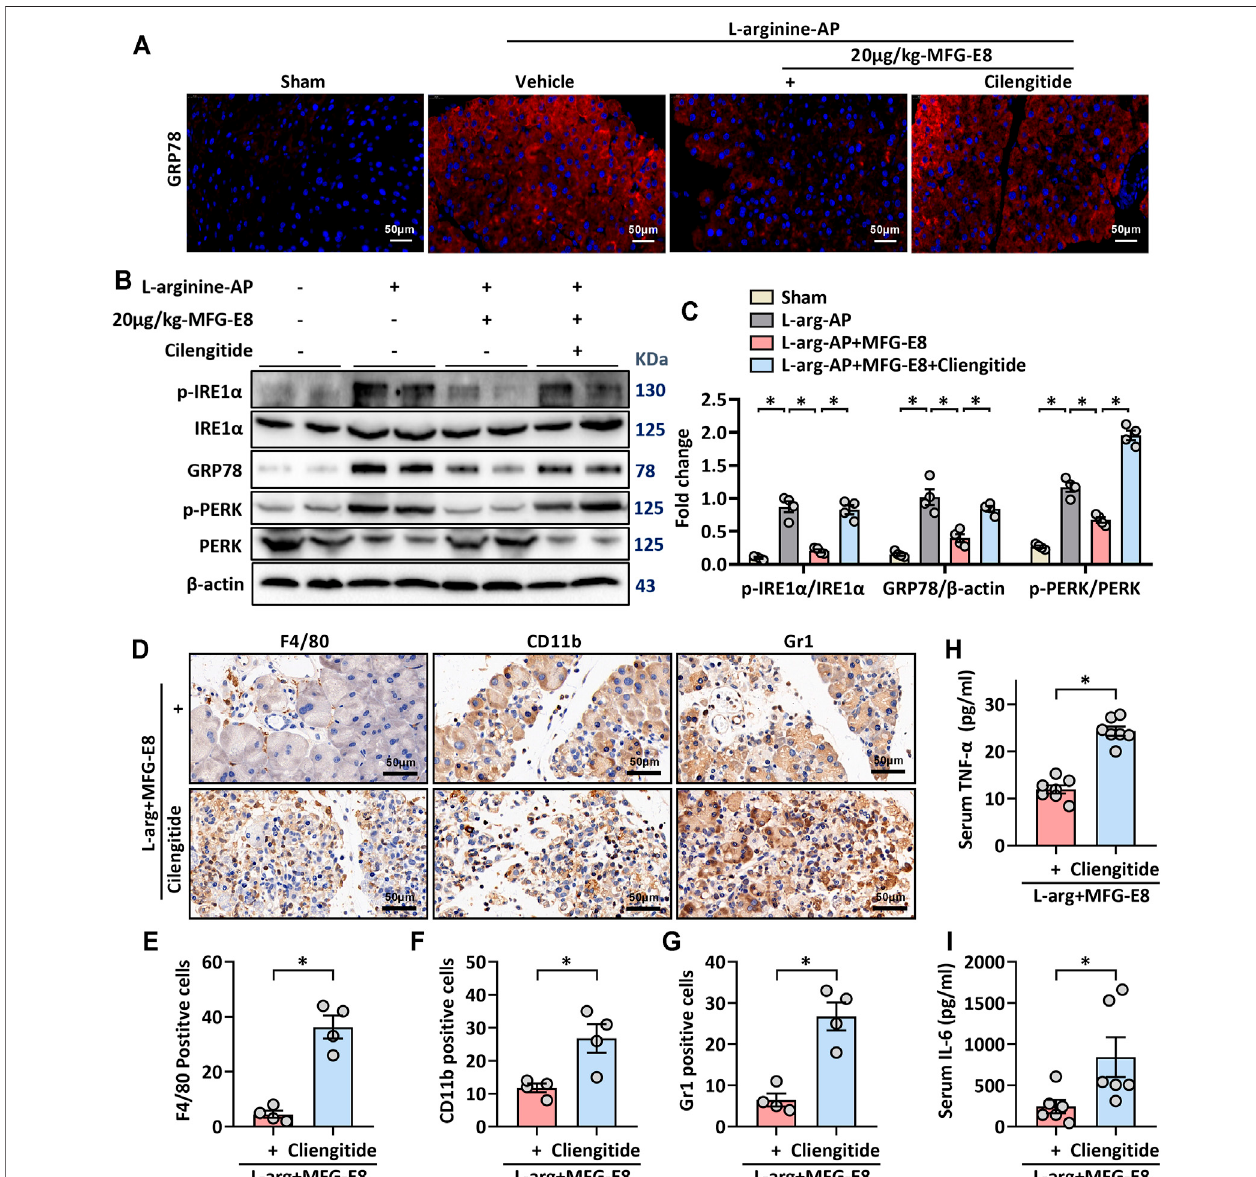
phospho-IRE1 α ,IRE1 α andCHOPinthepancreas; (D) RepresentativephotosofF4/80,CD11bandGr1staining; (E – G) QuantitativeofF4/80,CD11b,andGr1staining; (H) SerumIL-6levels; (I) SerumIL-6levels. n (cid:1) 4 – 6/group,errorbarsindicatetheSEM; p p < 0.05versusShamgroup;# p <